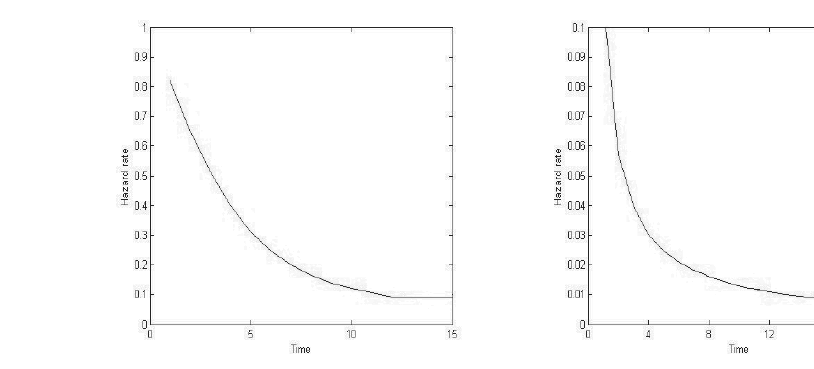
Figure 1 – Hazard rate of Mittag-Leffler count Figure 2 – Hazard rate of Mittag-Leffler count model ( α = 0.2).